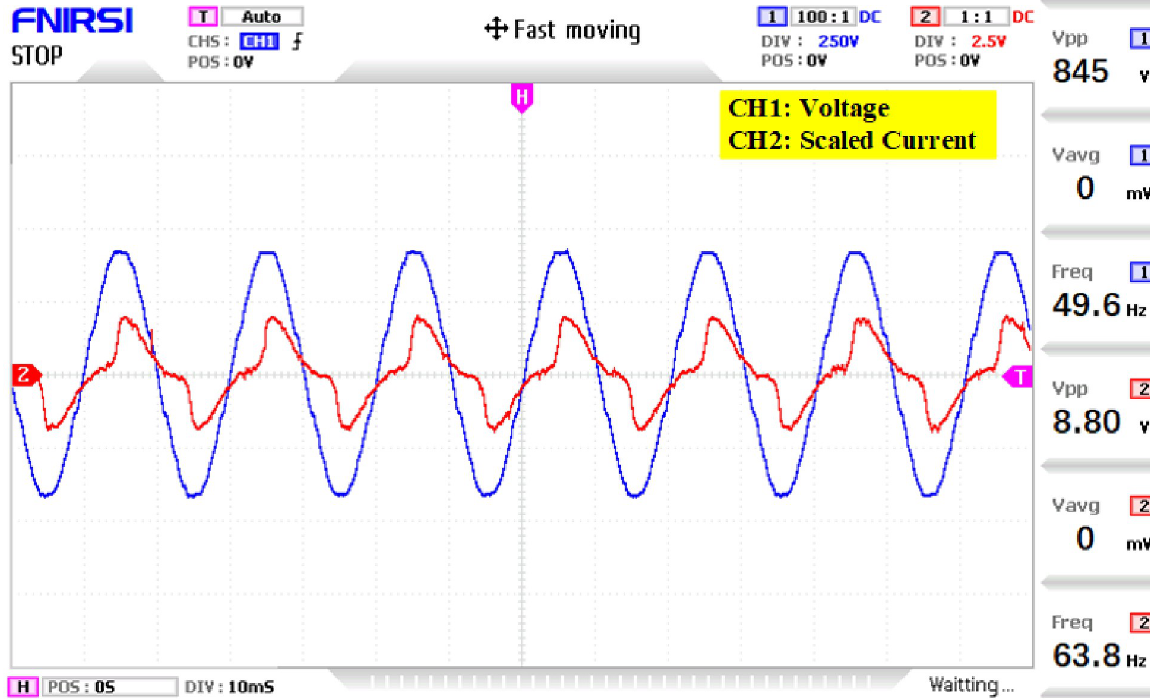
Fig 23. Experimental waveforms (voltage and current) at the output of 81-level MWMLI for non-linear lagging load.